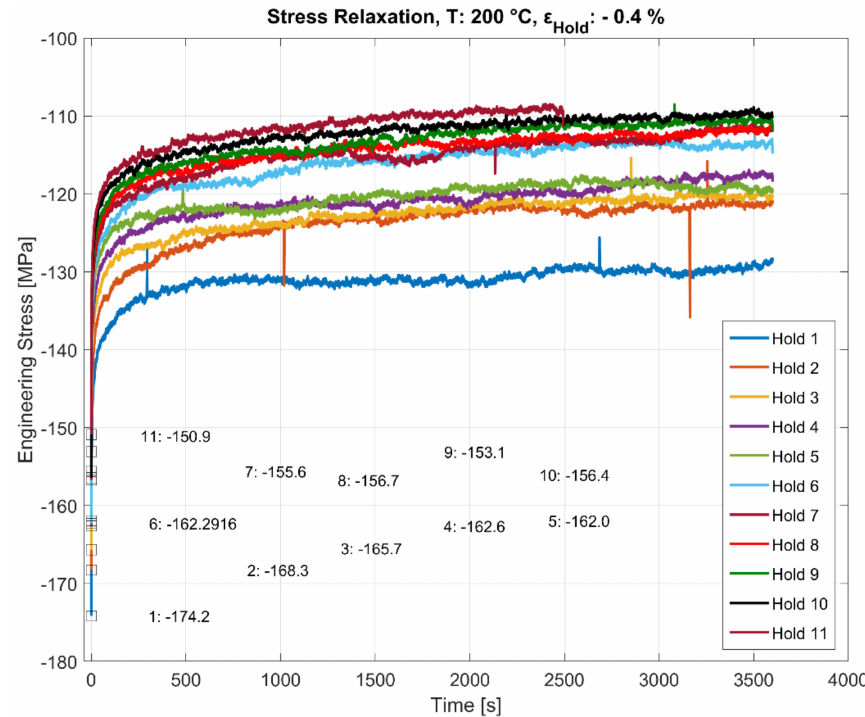
Figure 11. E ff ect of hold time on stress relaxation at 200 ◦ C with alternating fatigue loading and hold period. The start (trough) values at the beginning of each hold period (numbered 1–11) are stated in MPa.